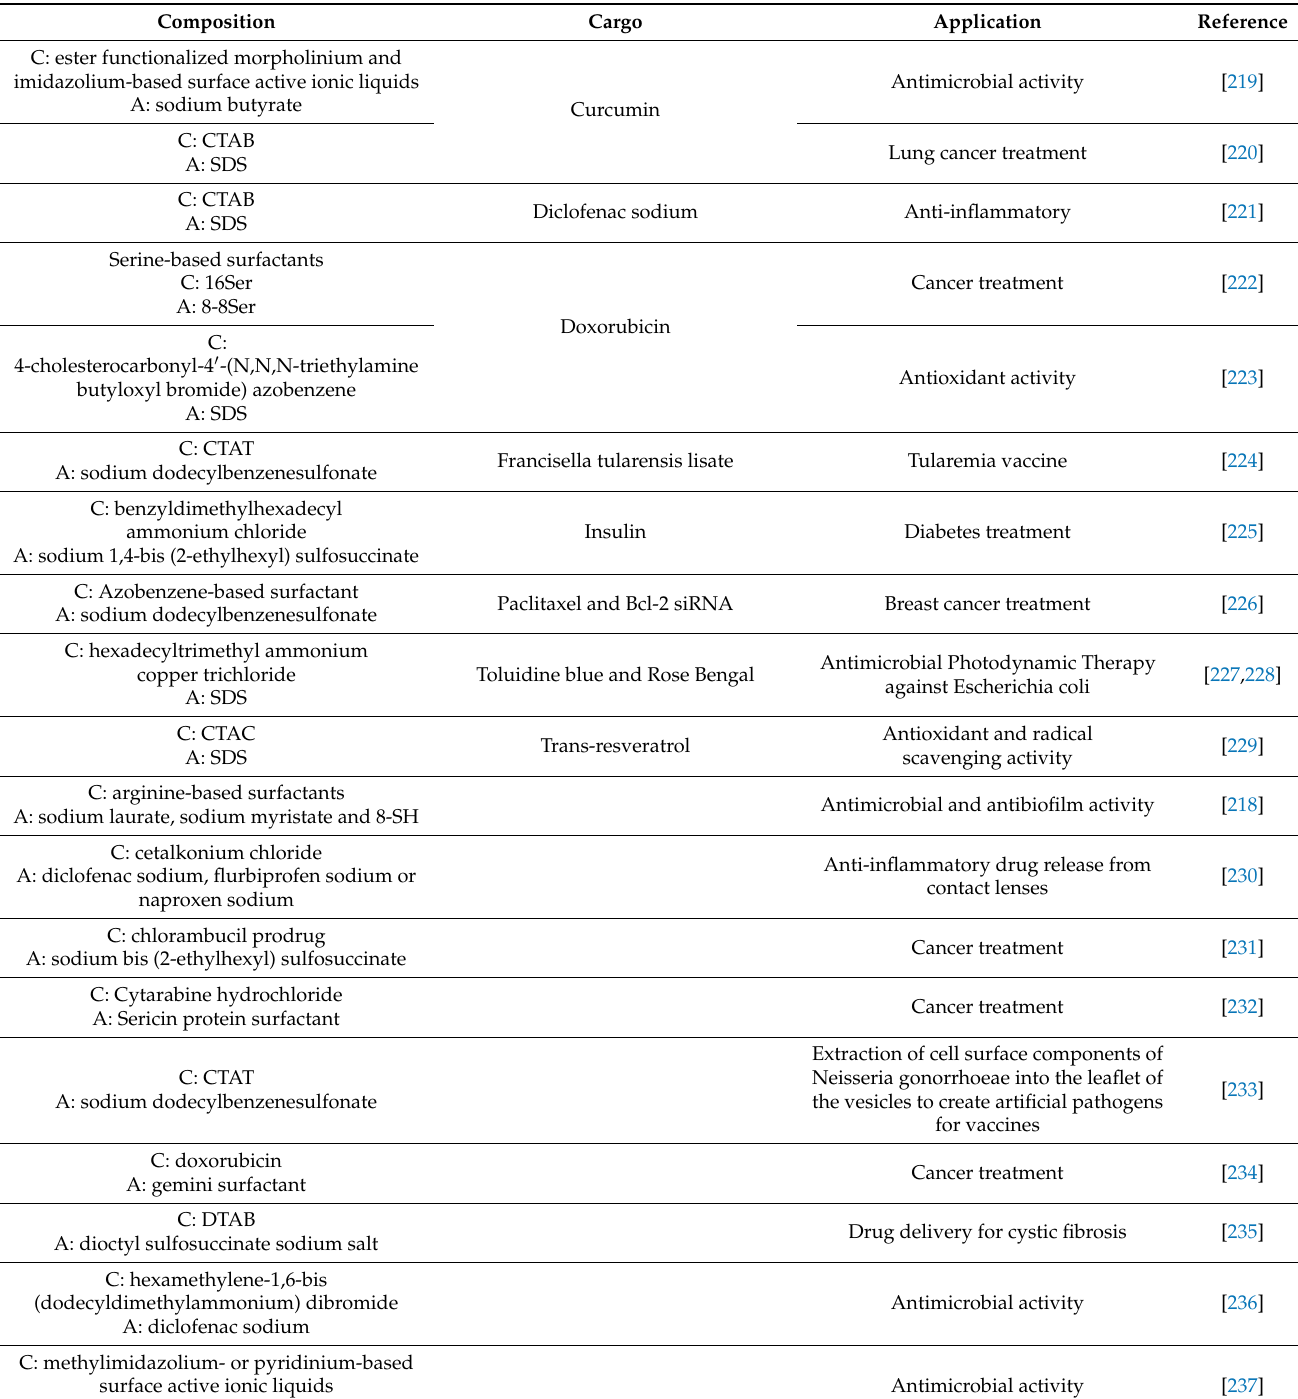
Table 8. Catanionic vesicles’ drug delivery applications. In the composition column, C is the cationic and A the anionic compound.